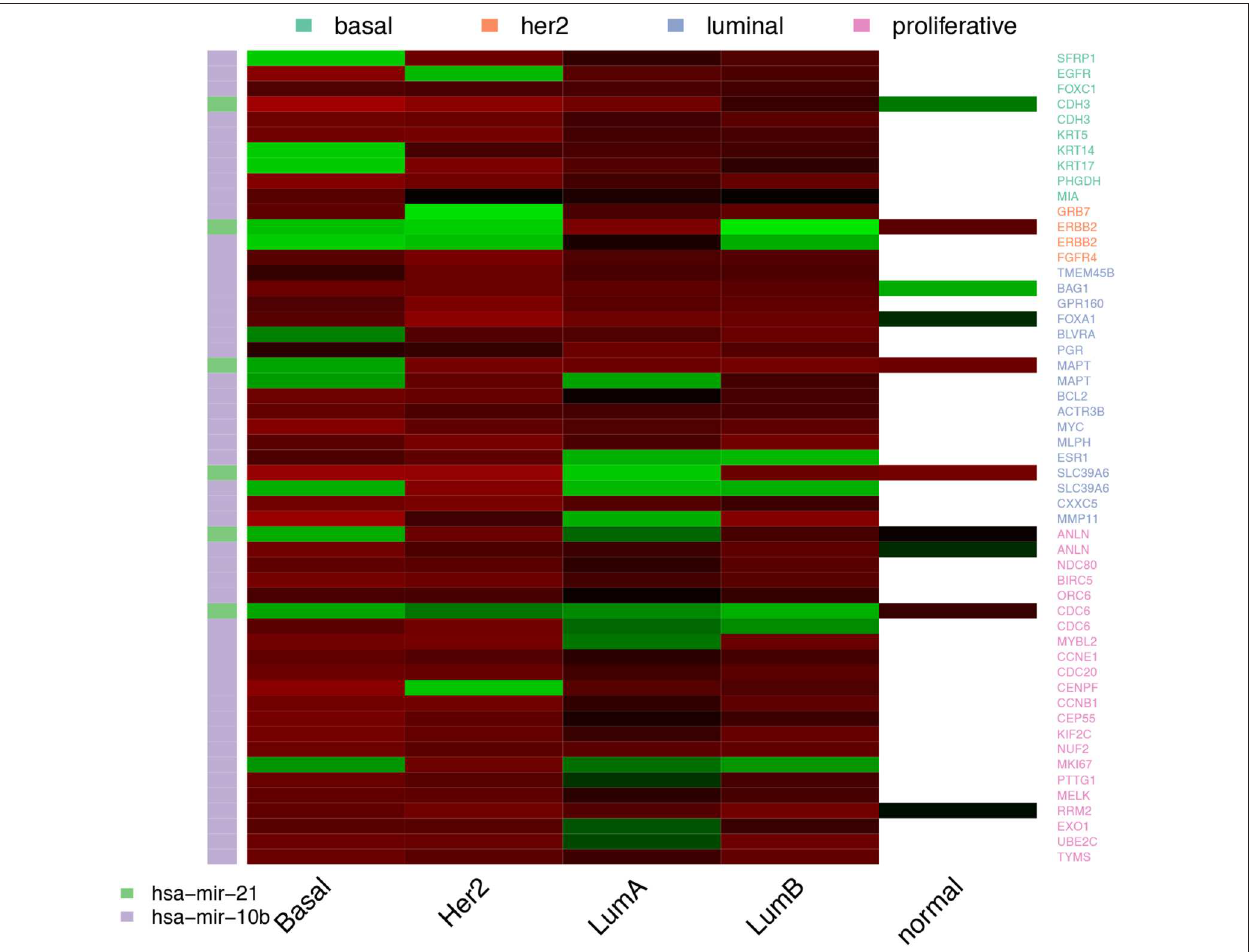
FIGURE 5 | miRNAs selected across the four cancer subtypes. miRNAs are represented by the color bar at the left. The highest positive coefficient value appears in bright red, the lowest negative coefficient is in bright green. Near zero coefficients look black. The white cells in the column of normal tissue means the predictors was not